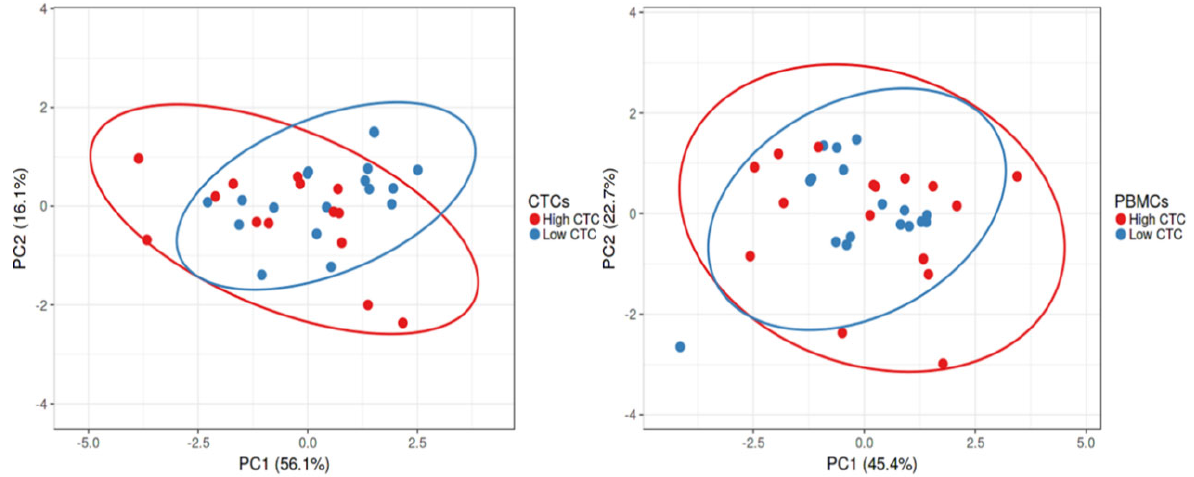
Figure 5. Relationship of the gene expressions ( P53 , APC , KRAS , c ‐ Myc , CD47 and CTLA ‐ 4 ) between high and low CTC groups in CTCs and PBMCs, in patients with CRC.